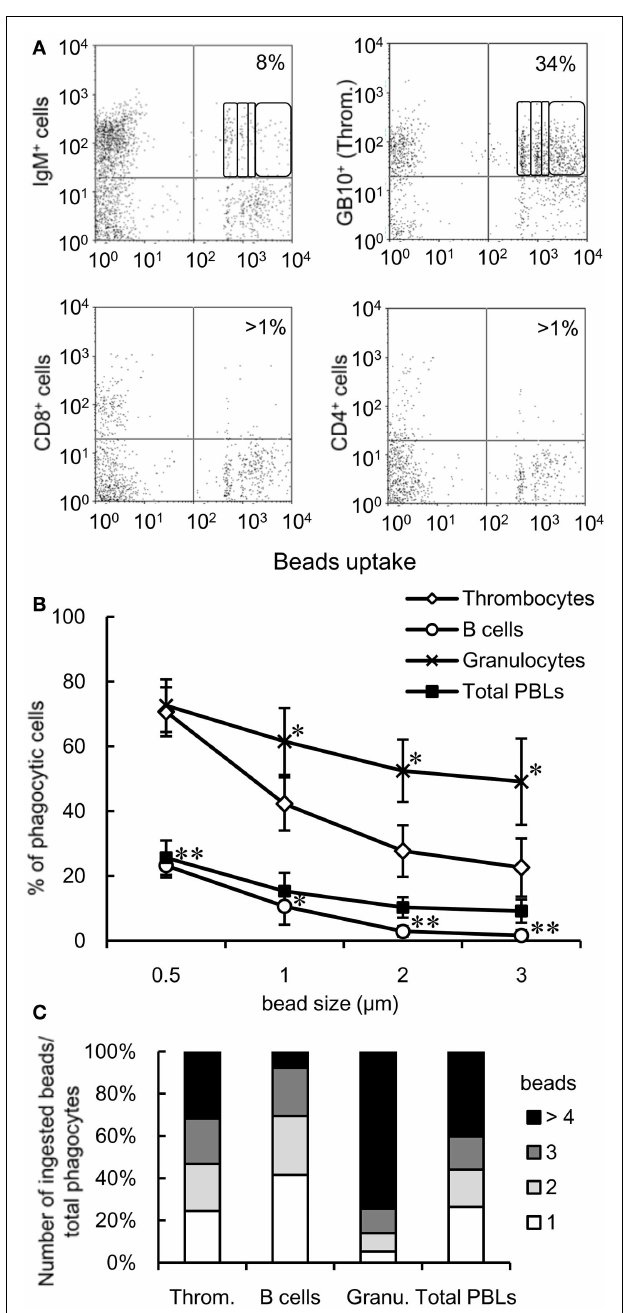
FIGURE 3 | Comparison of the phagocytic activities of each cell subpopulation is shown . (A) Flow cytometry of mAb-stained crucian carp PBLs incubated with fluorescent latex beads measuring 1 µ m in diameter for 3h at 25°C.The percentage indicates the rate of phagocytic cells in each mAb + cell population.The numbers (1, 2, 3, and > 4) indicate the number of ingested beads within each gated cell analyzed by fluorescence intensity on flow cytometry. Data are representative of three independent experiments. Throm., GB10 mAb + cells; CD4 + cells, 6D1 mAb + cells; CD8 + cells, 2C3 mAb + cells; IgM + cells, B12 mAb + cells. (B) Percentage of phagocytic cells in each cell population of common carp PBLs incubated with each size of beads for 3h at 25°C analyzed by flow cytometry. Data are expressed as the ( Continued